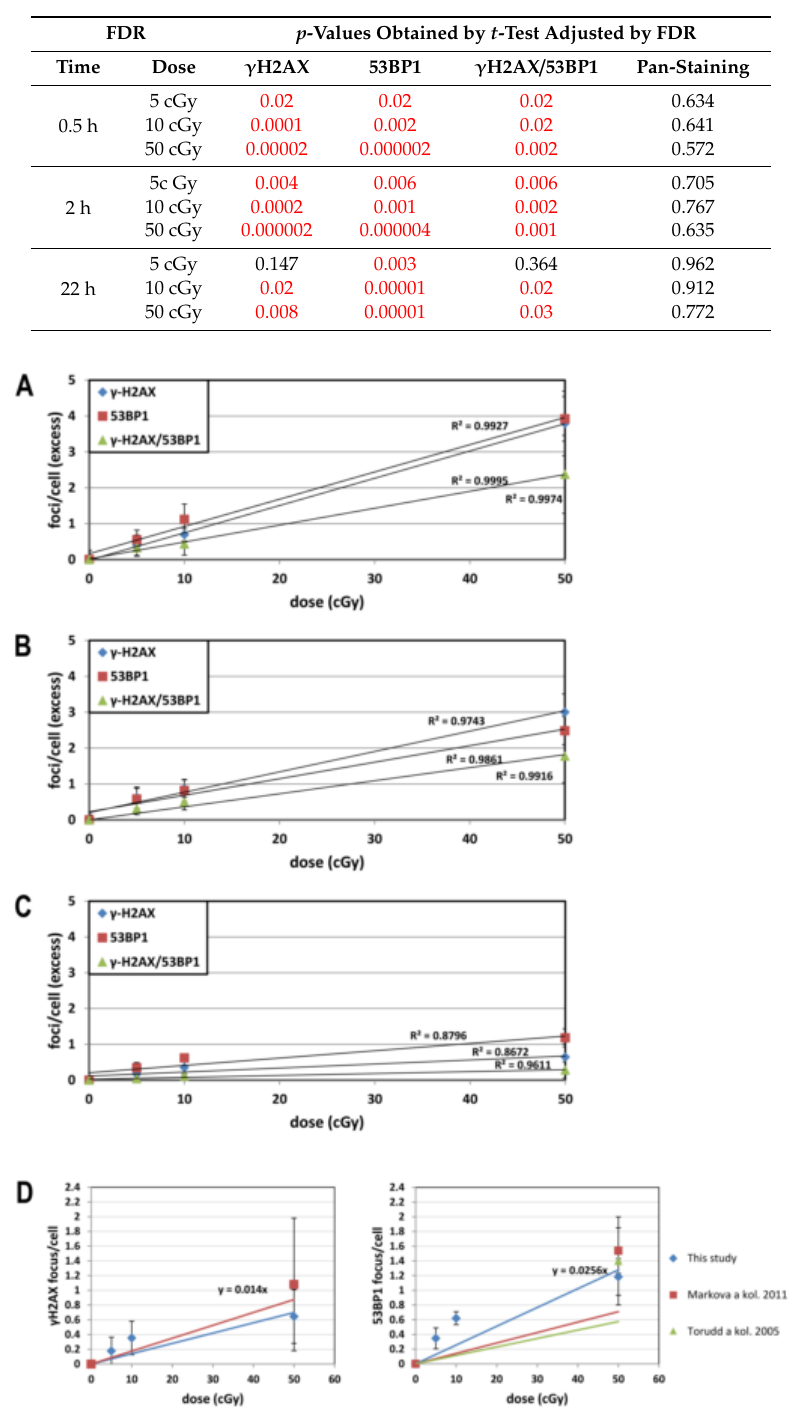
Figure 4. Linear fit for dose dependence of γH2AX, 53BP1, and γH2AX/53BP1 foci. Dose dependence of IRIF and linear regression along with the coefficient of determination R 2 is shown for different post-irradiation time points: ( A ) 30 min, ( B ) 2 h, and ( C ) 22 h. Data from 3 experiments are shown for each dose (0, 5, 10, and 50 cGy). Panel ( D ) shows linear responses for residual foci measured 22 h post-irradiation (blue) and our extrapolations from high doses reported by Markova et al. [31] (red) and Torudd et al. [32]